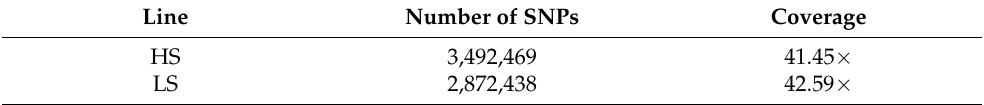
Table 1. Sequencing and mapping data of HS and LS lines of Japanese quail